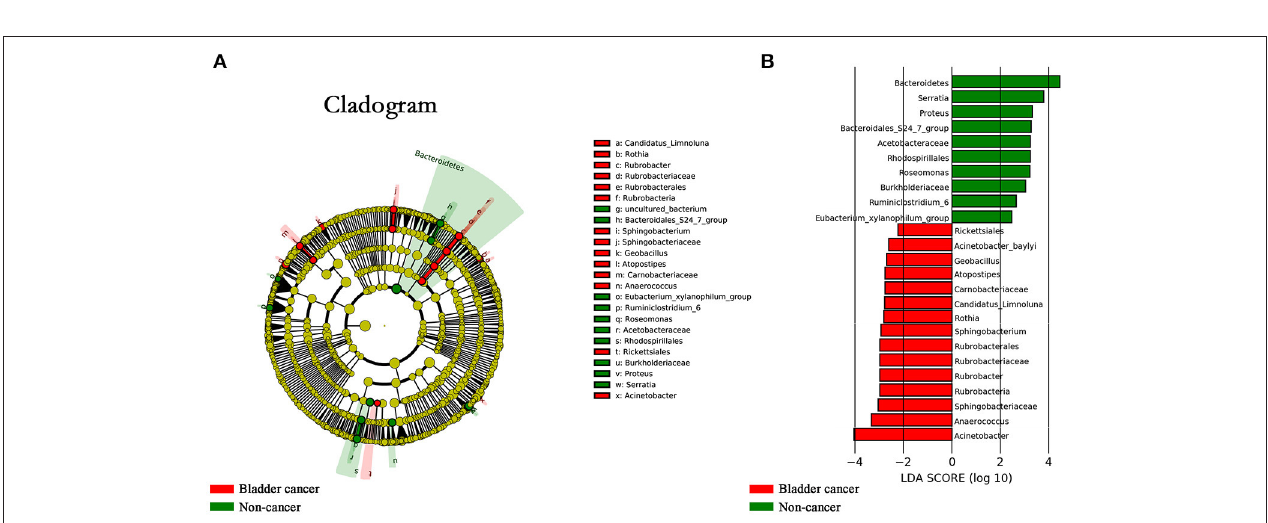
FIGURE 4 | Microbial taxa associated with bladder cancer. (A) Cladogram representation of the urinary microbial taxa associated with bladder cancer (red) and non-cancer (green). (B) Association of specific microbiota taxa with cancer group and non-cancer group by linear discriminant analysis effect size (LEfSe). Red indicates taxa enriched in cancer group and green indicates taxa enriched in non-cancer